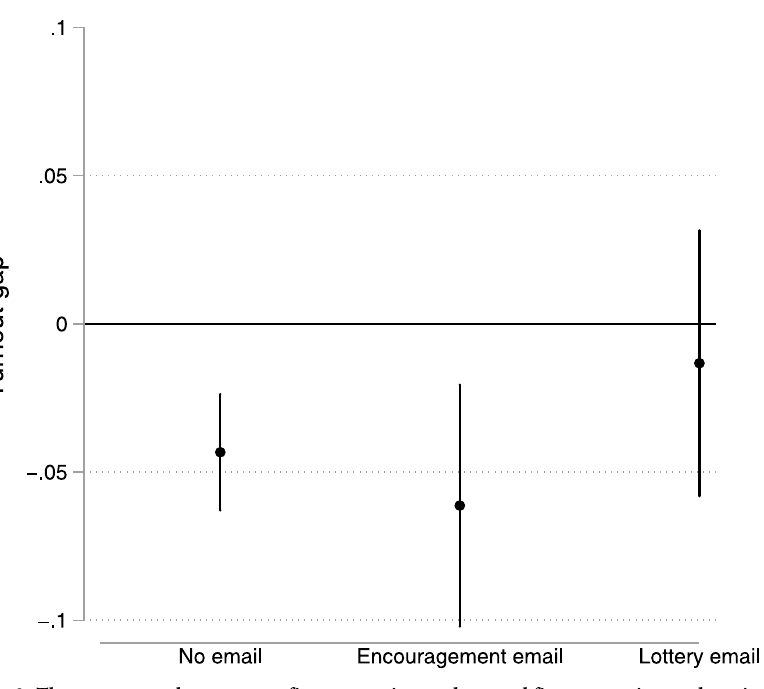
Fig 2. The turnout gap between non-first-generation students and first-generation students in each condition. Plot shows difference in proportion of non-first-generation and first-generation students voting in election. Vertical lines are 95% confidence